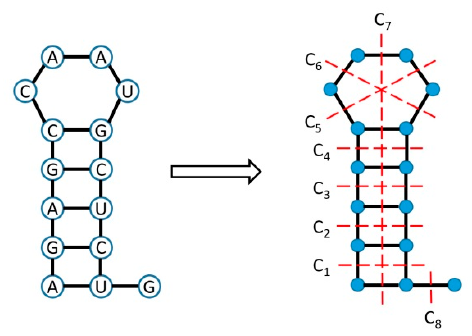
Figure 2. RNA secondary structure of a bacteriophage (Virus Orthologuous Group VOG03380, subVOG 8) and its full graph representation. The elementary cuts that are used in Table 3 for calculating the Szeged index are drawn for illustration.